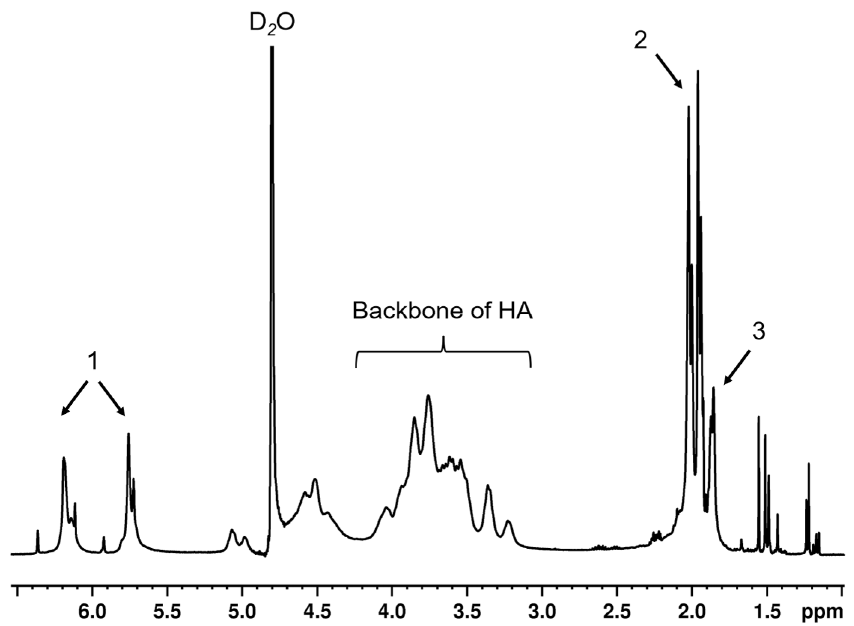
Figure 1. 1 H NMR spectra of methacrylated hyaluronic acid with 80–100% degrees of grafting. The peaks no. 1, 2, and 3 represent 2 protons on methacrylate alkene, 3 protons of the methyl group on the methacrylate, and another 3 protons of the methyl group of HA.